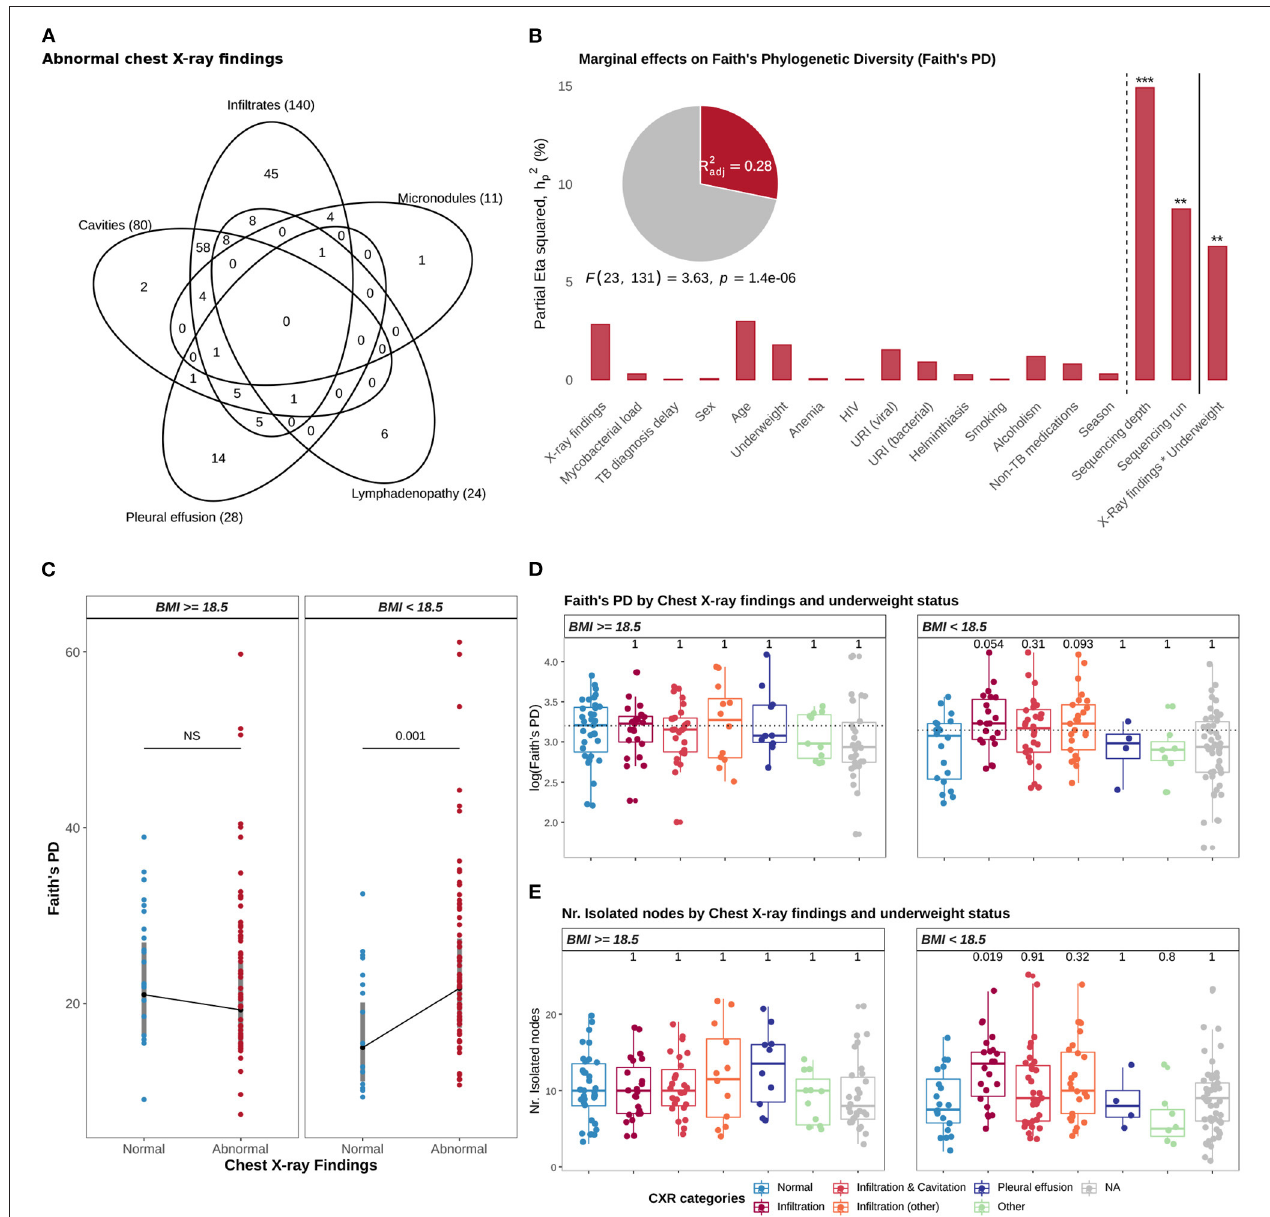
FIGURE 4 | Associations with Faith’s phylogenetic diversity (PD). (A) Venn diagram showing the distribution of TB patients across the five types of lesions comprising abnormal CXRs findings. (B) The graph illustrates a multi-way ANCOVA model testing for associations with Faith’s PD (log10); the height of the bars correspond to the proportion of Faith’s PD variance accounted by variables included in the model (marginal effect sizes), and measured by the partial Eta squared statistic ( h 2 p , see methods); the adjusted R-squared statistic, the significance of the model and of the variables are shown: * p ≤ 0.05, ** p ≤ 0.01, *** p ≤ 0.001, and **** p ≤ 0.0001. (C) Plot showing the estimated marginal means of Faith’s PD by Chest x-ray findings and underweight status, based on the ANCOVA model showed in B; gray bars correspond to 95% confidence intervals of the estimated means. (D) Distribution of Faith’s PD (log10), by CXR categories and underweight status; Student t -tests were applied for pairwise comparison of means (reference: “Normal” CXRs). (E) Distribution of the number of isolated nodes, from the genus-level interaction network, by CXR categories and underweight status; Wilcoxon rank-sum tests were applied for pairwise comparison of means (reference: “Normal” CXRs). In (D,E) , CXR categories were defined as “Normal” (none of the five CXR signs), “Infiltration” (only parenchymal infiltrates observed in CXRs), “Infiltration and Cavitation” (infiltrates with cavities, but no additional CXR signs), “Infiltration (other)” (infiltrates with any other CXR sign, accompanied or not by cavities), “Pleural effusion” (no additional CXR signs) and “Other” (patients without parenchymal lesions and one patient with pleural effusion and cavities). In (D,E) , p -values were adjusted for multiple comparisons with Holm-Bonferroni Method.